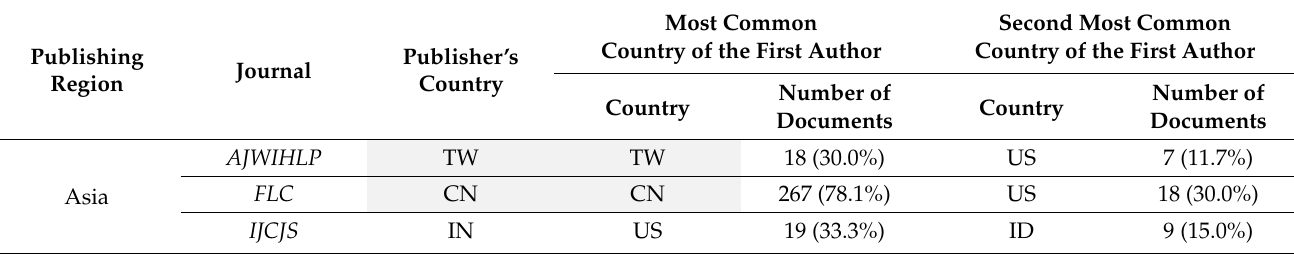
Table 5. Frequency of Publishers’ Country and the First Author’s